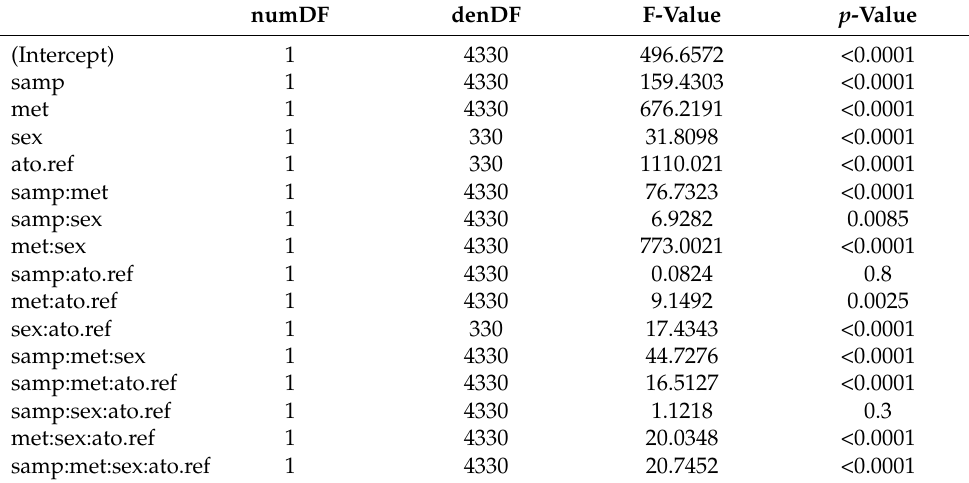
Table 4. Analysis of Variance of the Linear Mixed Effects model for differences (D) between estimates and references values of Age at Take-off (ATO) with effects of sample (samp, 1–7), sex (sex, males, females), estimation method (met, FPCA, SITAR), and reference ATO (ato.ref, age in years), including all interactions. numDF denDF